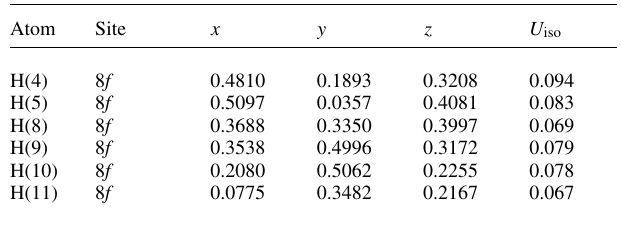
Table 2. Atomic coordinates and displacement parameters (in Å 2 )